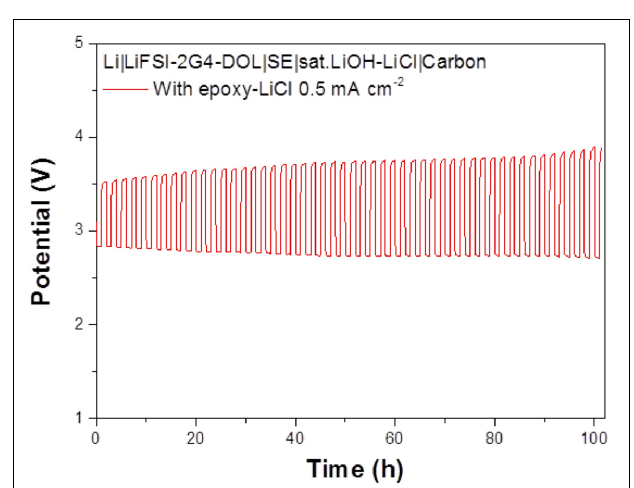
FIGURE 7 | Impedance profiles of symmetric stainless steel (SUS)/saturated LiOH and LiCl aqueous solution/LAGTP-E-LiCl/saturated LiOH and LiCl aqueous solution/symmetric stainless steel (SUS) at 25 ◦ C as a function of the storage period.